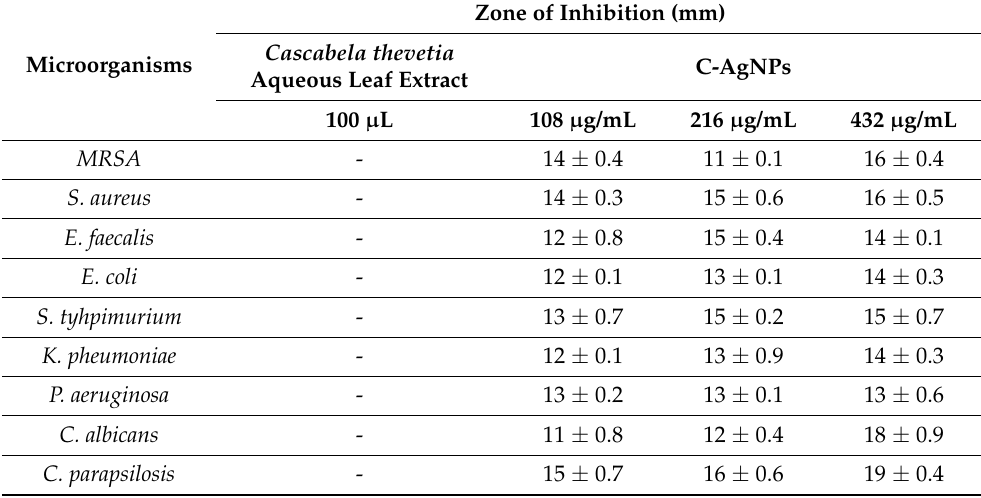
Table 1. The estimation of the zone of inhibition diameters formed by C-AgNPs against the tested bacterial and fungal